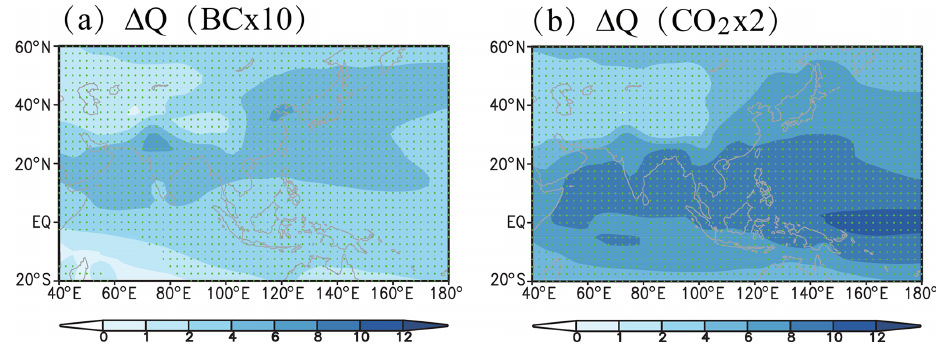
Figure 7. Changes in multimodel mean (MMM) of the MJJAS vertically integrated water vapor ( (cid:49)Q ; unit: gm − 2 ) under (a) increasing BC and (b) GHGs. Dotted regions indicate where the MMM is more than 1 standard deviation away from